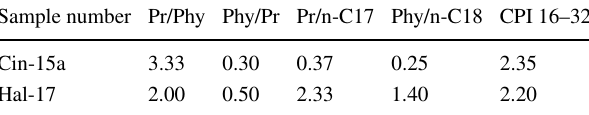
Table 3 Pr/Ph ratios and CPI values of the studied